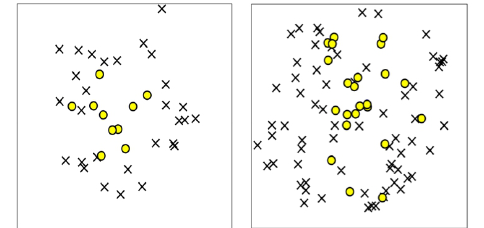
Figure 8. The xy offsets to the positioned branch tips from the centers of the pseudoechoes that had zero (x) or positive (o) silhouette. The scales differ: left subfigure shows the 1-km ALS60 strip in a ± 30-cm box and the right subfigure shows the offsets in the Riegl 750-m LMS-Q680i data in a ± 50-cm box.